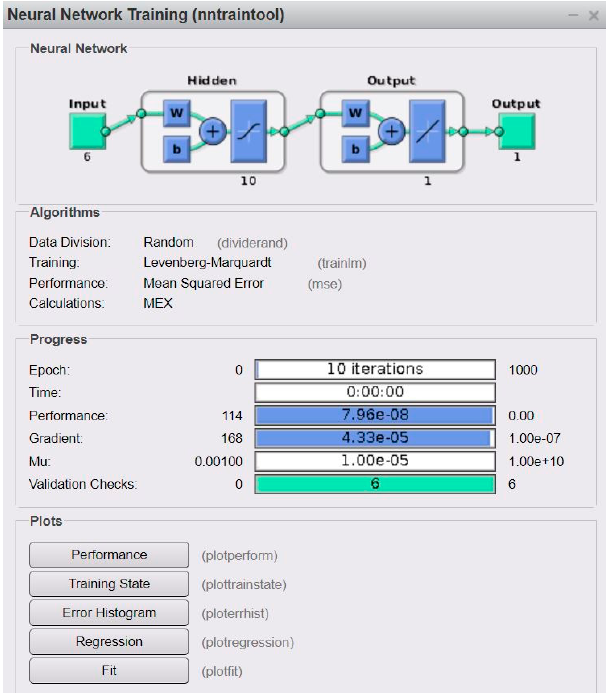
Figure 24 . Neural network training .